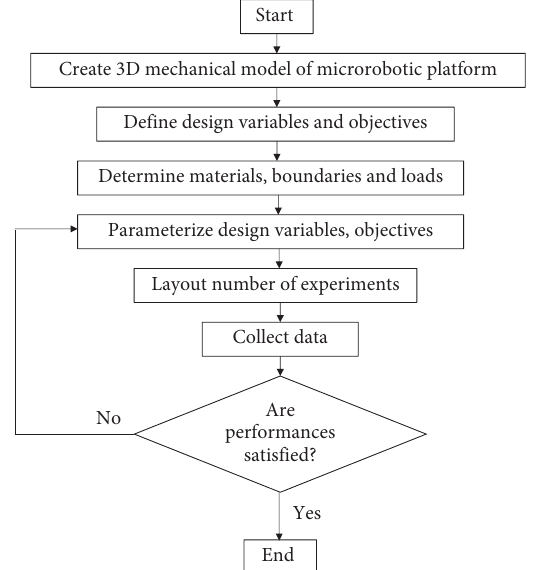
Figure 10: Proposed simulation scheme for microrobotic platform.